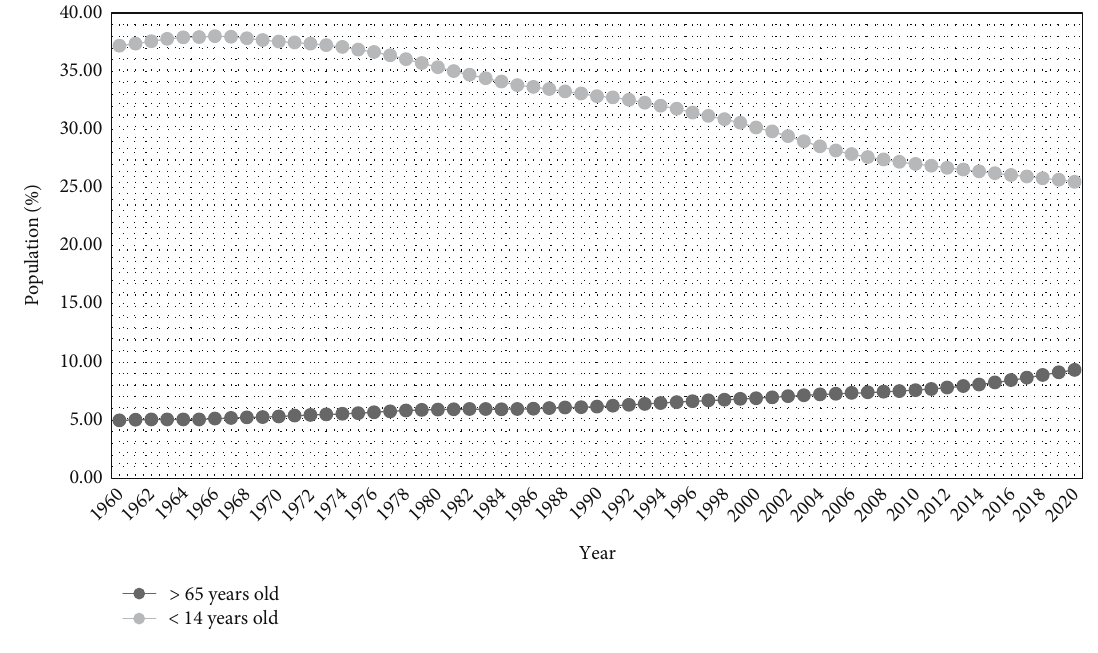
Figure 1: Evolution of the population distribution.